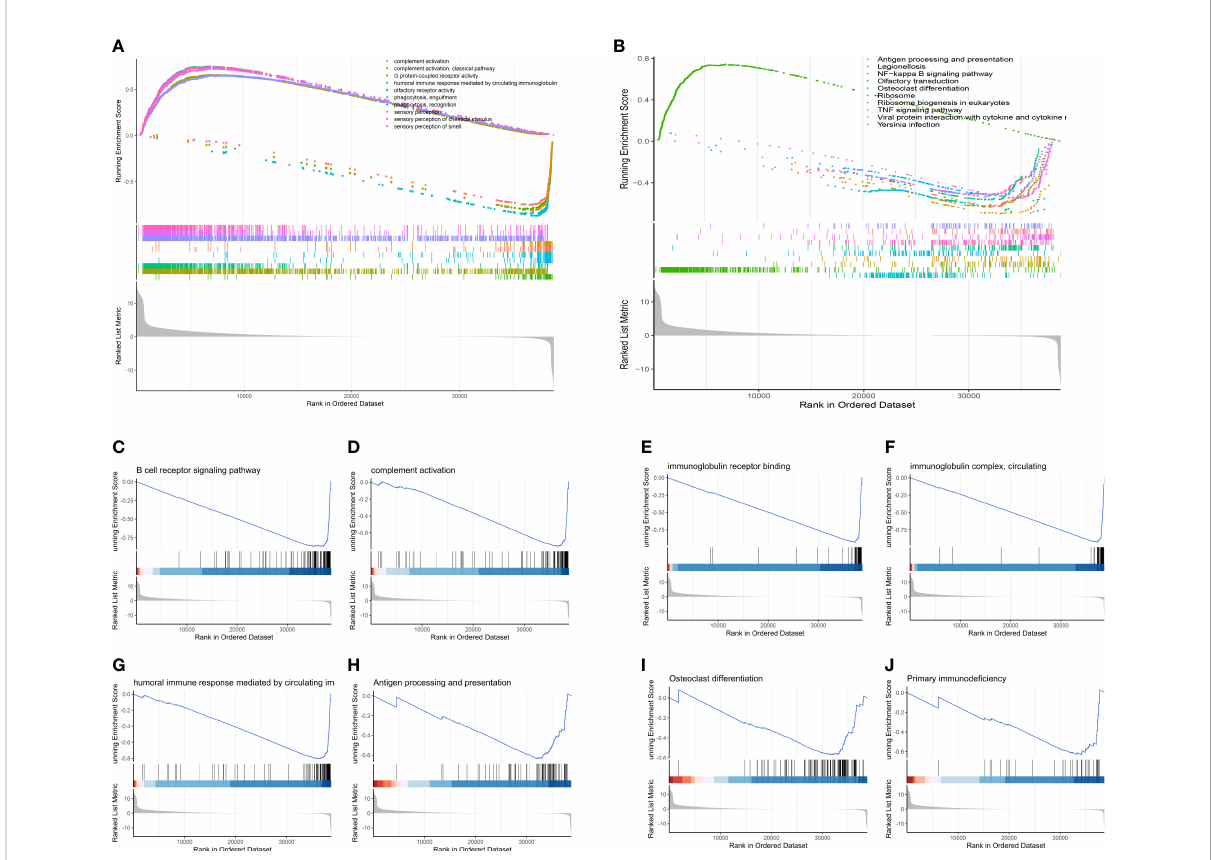
FIGURE 10 GSEA analysis of the two risk groups. (A) The top 10 changed pathways conducted utilizing the GO gene set. (B) The top 10 changed pathways conducted utilizing the KEGG gene set. Both two pictures show a downregulated immune condition, which indicates that dysfunction of immune system plays a vital role in the progression of OS patients. (C-J) Several immune-related and bone remodeling pathways were selected from the GSEA analysis. (C) B cell receptor signaling pathway. (D) Complement activation. (E) Immunoglobulin receptor binding. (F) Immunoglobulin complex, circulating. (G) Humoral immune response mediated by circulating immunoglobulin. (H) Antigen processing and presentation. (I) Osteoclast differentiation. (J) Primary immunode fi